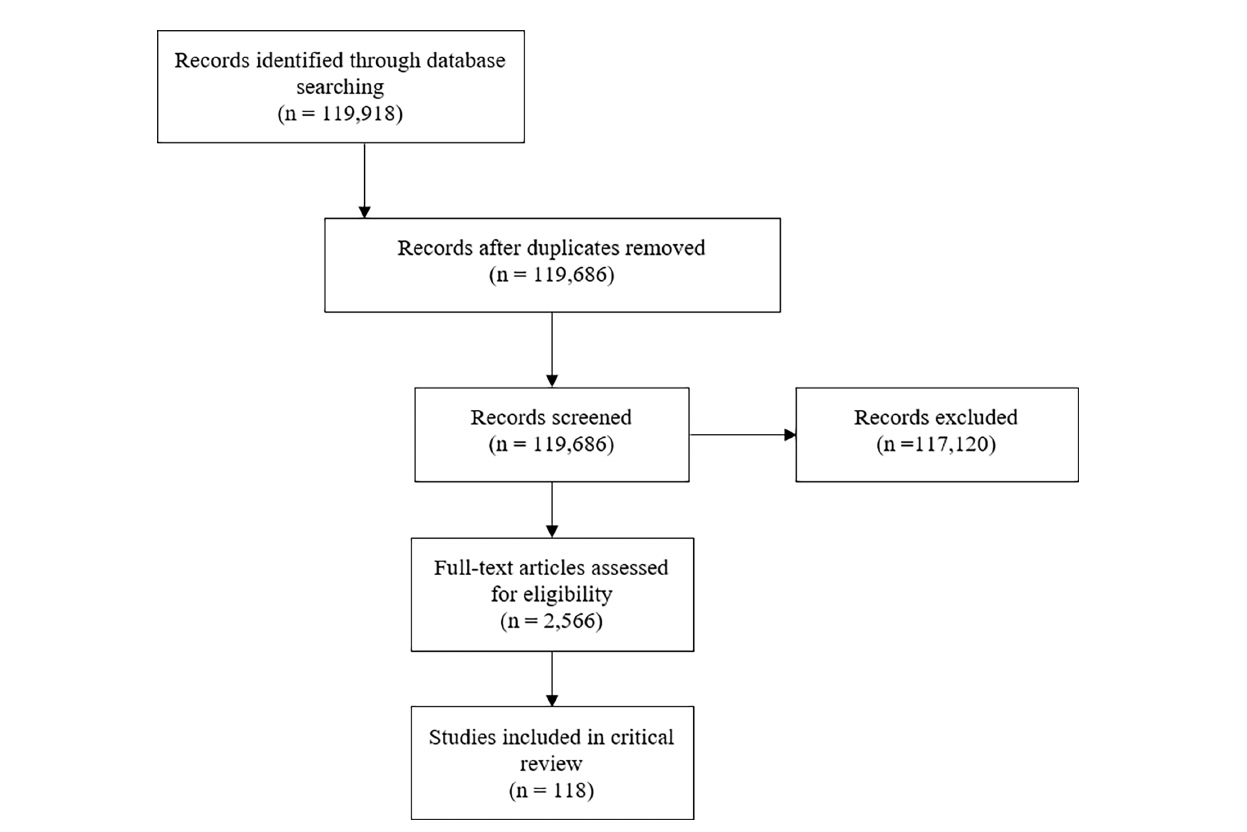
FIGURE 1 | PRISMA